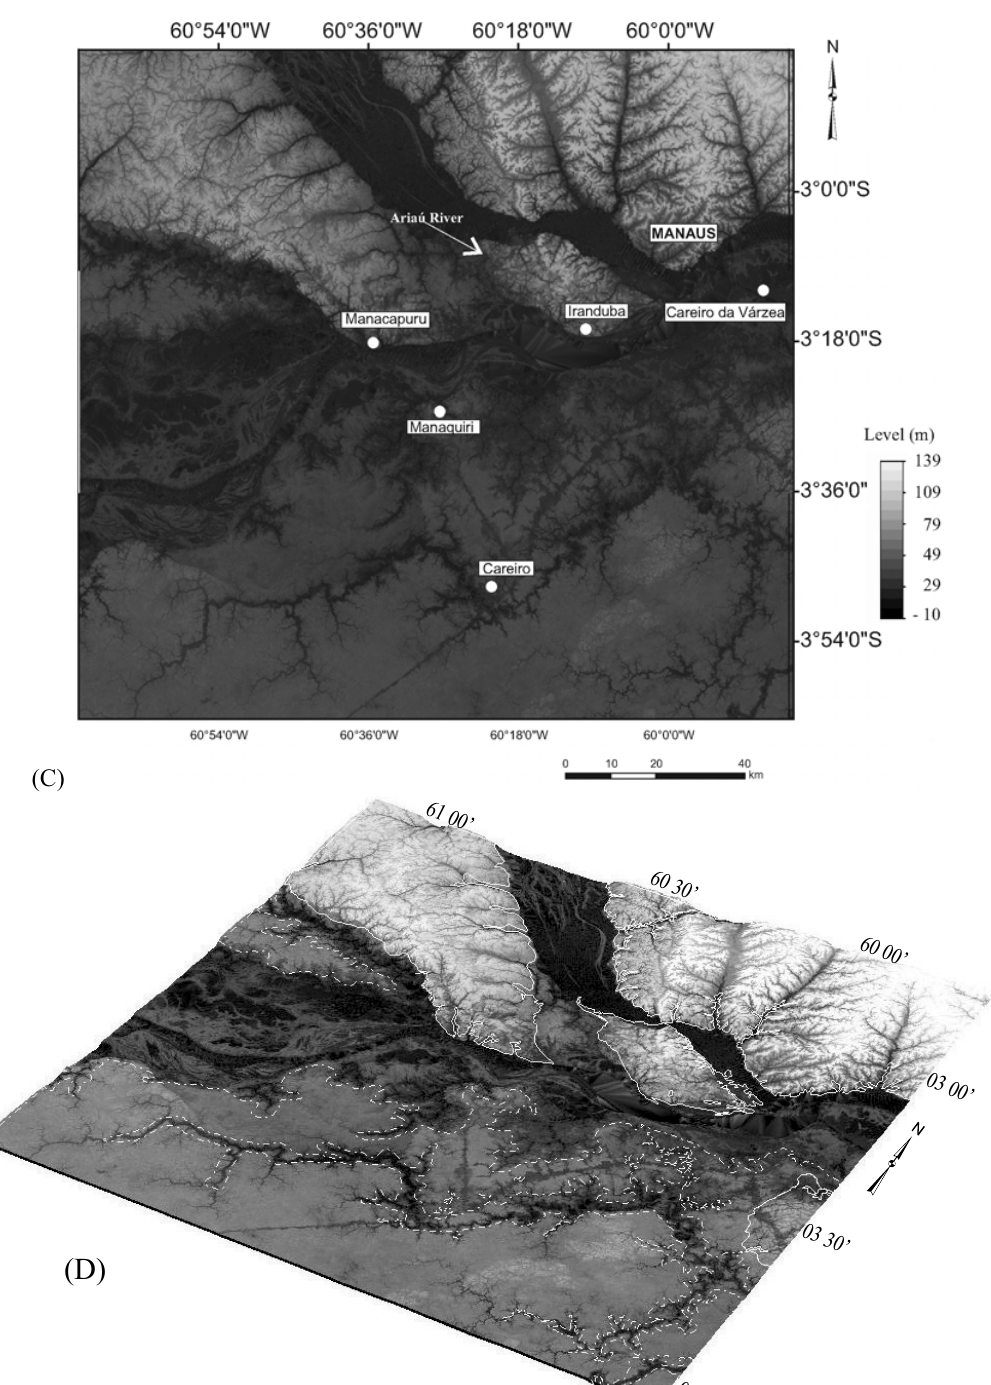
Fig. 3 – SRTM model of the southwestern region of Manaus (Amazon-Brazil). (C) SRTM model with the topographic contour lines (meters). (D) 3-D visualization of the SRTM DEM with a vertical exaggeration of 80 times.